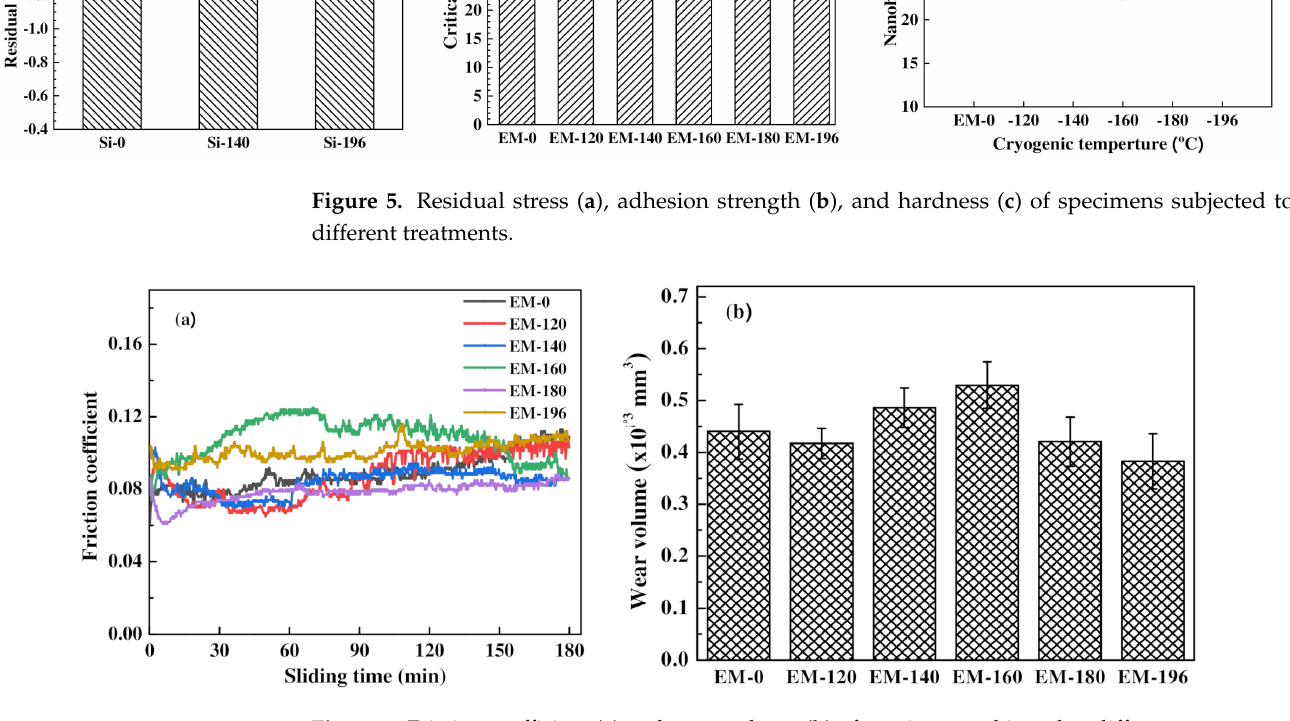
Figure 6. Friction coefficient ( a ) and wear volume ( b ) of specimens subjected to different